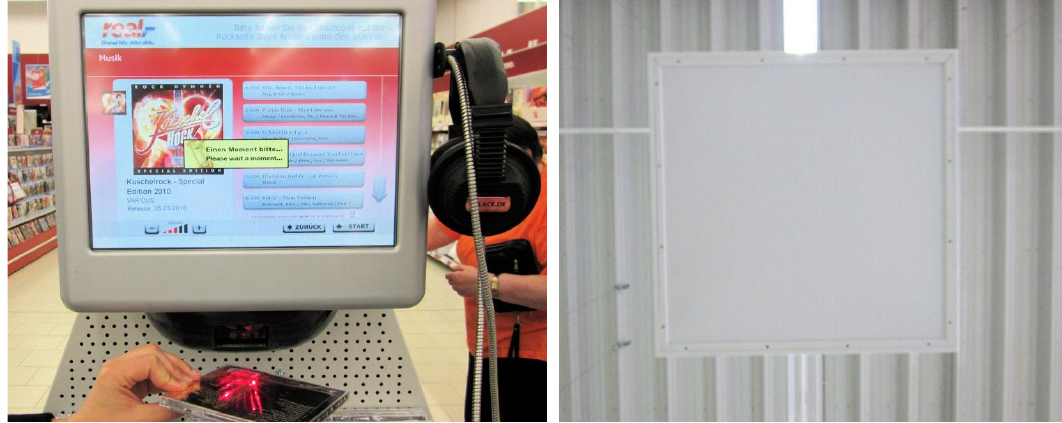
Figure 9. Interactive media booth for customer use at the Metro Future Store: ( Left ) The user interface with a touch screen and a bar code scanner, and ( Right ) the overhead-installed directional speaker (figure adapted with permission from Petri Saarikko)